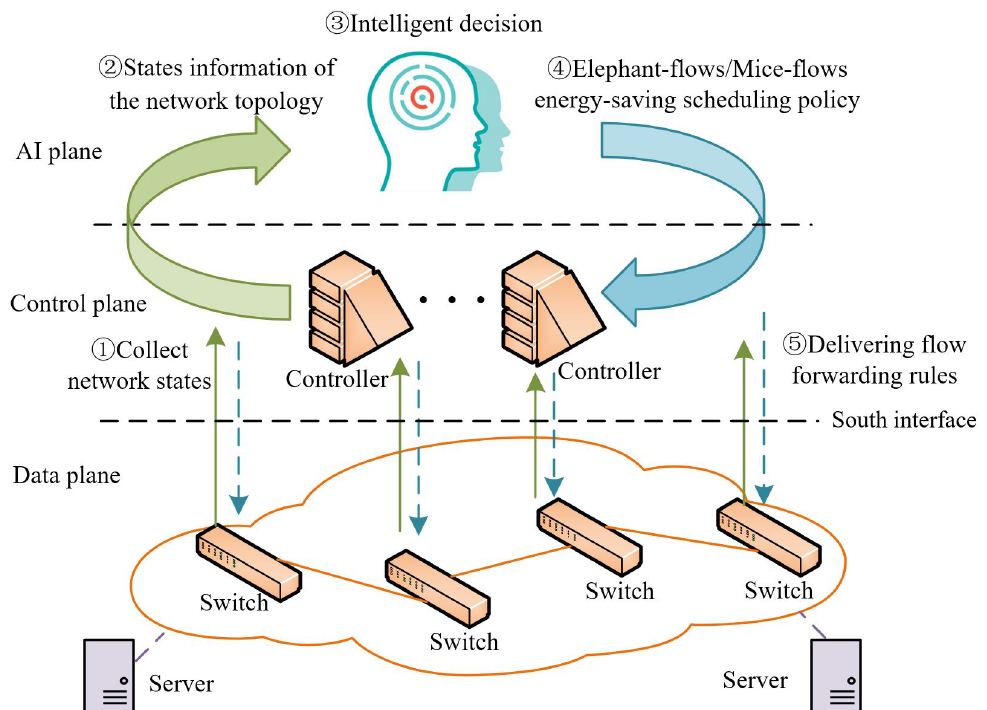
Figure 1. Energy-saving routing traffic scheduling architecture under